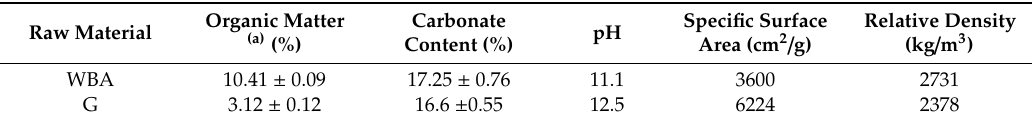
Table 2. Organic matter, carbonate content, pH, specific surface area and relative density of wood bottom ash (WBA) and GeoSilex